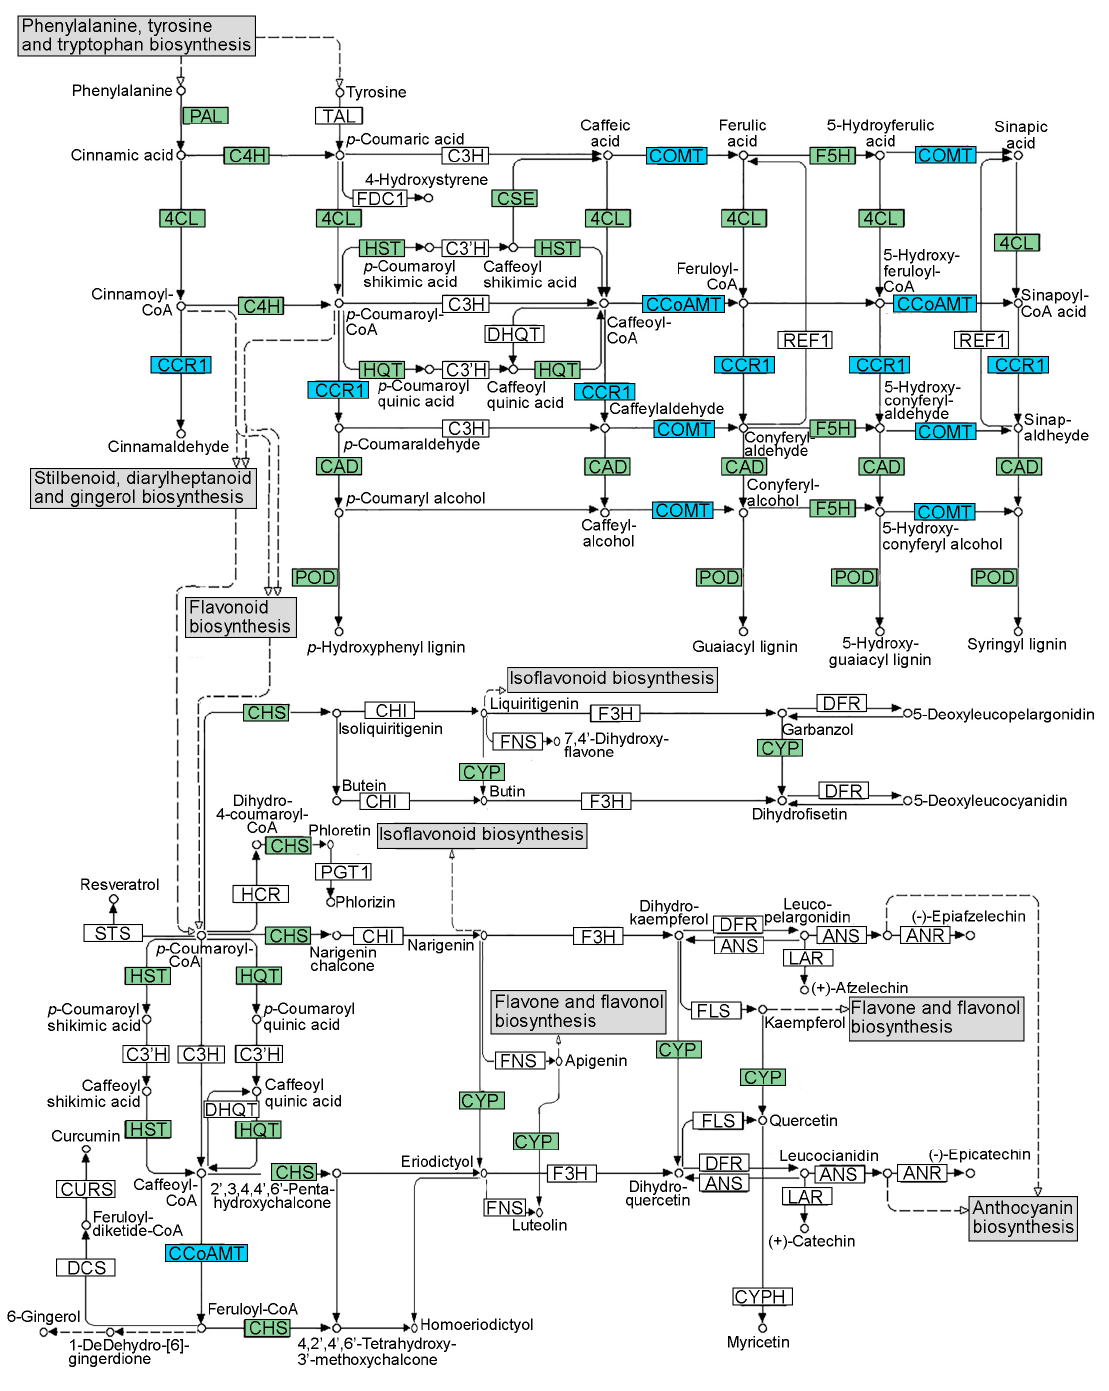
Figure 4. Schematic representation of secondary metabolite pathway map for phenylpropanoid, flavonoid, stilbenoid, diarylheptanoid, and gingerol biosynthesis. The positions in the map of the proteins encoded by the differentially expressed genes (DEGs) modulated in the LM and TR ecotypes, in the sanitized (S) vs. non-sanitized (NS) samples, are highlighted with blue boxes. The position of the proteins encoded by the DEGs observed only in the analysis between LM-S vs. LM-NS, is highlighted with green boxes. Protein abbreviations: 4CL, 4-coumaric acid:CoA ligase; ANS, anthocyanidin synthase; ANR, anthocyanidin reductase; C3H, p -coumaric acid 3-hydroxylase; C3 (cid:48) H, p -coumaroyl- shikimic acid/quinic acid 3-hydroxylase; C4H, cinnamic acid 4-hydroxylase; CAD, cinnamyl-alcohol dehydrogenase; CCoAOMT, caffeoyl-CoA O -methyltransferase; CCR1, cinnamoyl-CoA reductase 1; CHI, chalcone isomerase; CHS, chalcone synthase; COMT, caffeic acid 3- O -methyltransferase; CSE,